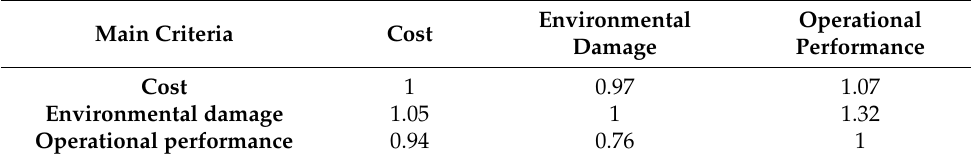
Table 5. Defuzzification pairwise comparison matrix for main criteria.